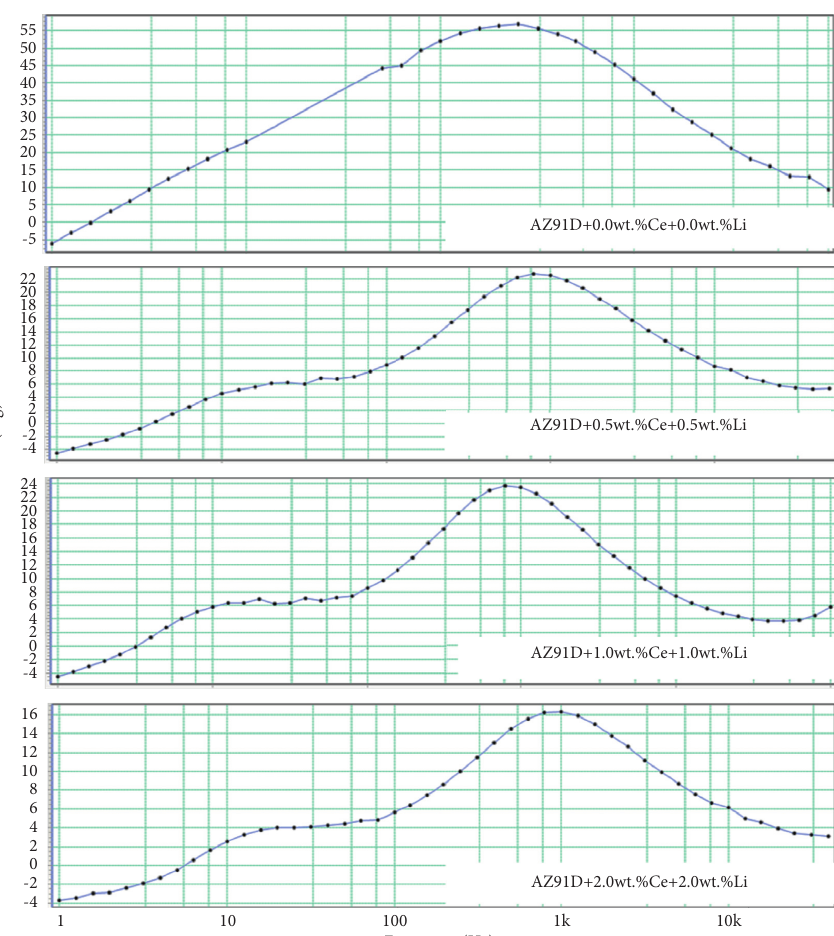
Figure 13: Bode plots for as-cast and Ce and Li added AZ91D measured in a 3.5 wt% NaCl solution at their open-circuit